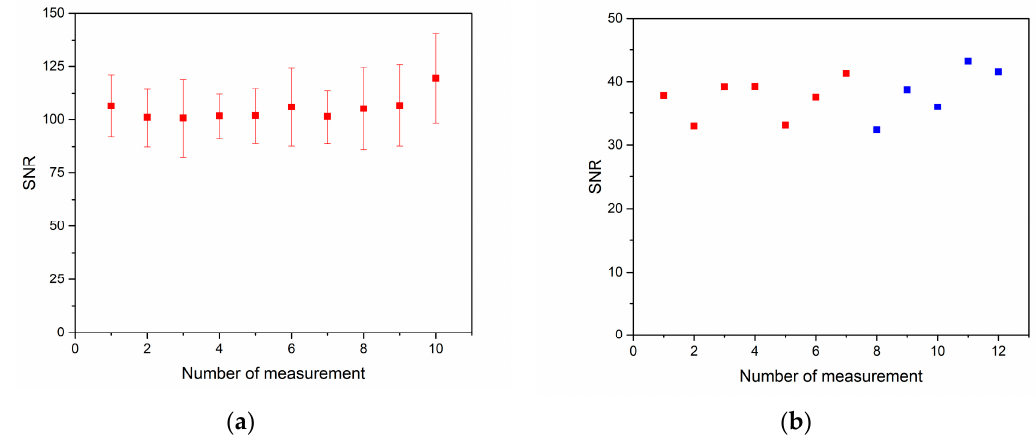
Figure 2. ( a ) The average signal-to-noise ratio of 10 consecutive measurements of BAM 308. Each measurement is a 5 × 5 map, where one spectrum was accumulated from five pulses in one spot. Signal-to-noise ratio (SNR) was calculated in each spectrum as the ratio of Zn I 334.50 nm intensity and respective background in the proximity of analytical line. Then, each point in the plot was statistically obtained as an average of SNR values from 25 spectra. ( b ) The signal-to-noise ratio of zinc solution drop on soft tissue represented by 12 data points, seven red ones (analyzed on 12 July 2019) and five blue ones (analyzed on 23 September 2019). Each SNR in the graph is an average value of SNR from spectra related to one Zn drop. It is not possible to add error lines because SNR is influenced by heterogenous distribution of analyte concentration, therefore, only the average values can be compared.